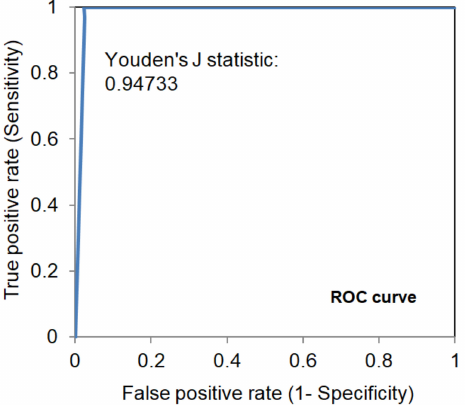
Figure 5. Receiver operating characteristic (ROC) analysis of S protein coated SAW biosensors.